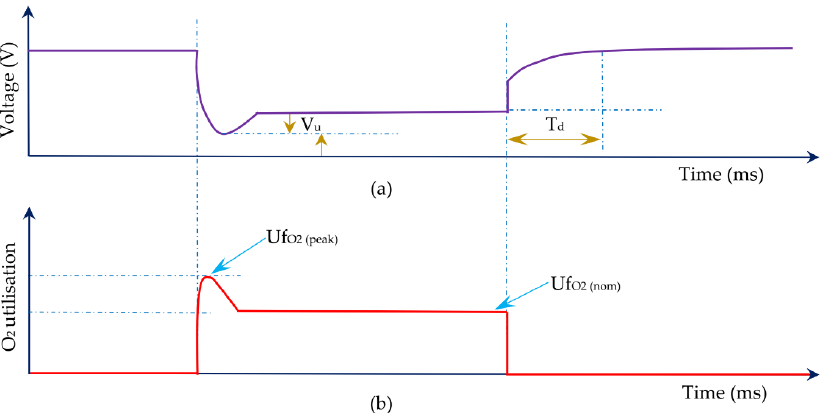
Figure 4. Profiles of voltage ( a ) and O 2 utilisation ( b ) vs. time. Reproduced from [19] under the Creative Commons Licence. Overall, the scheme of the FC stack, including 45 cells, and the details of the block for connection to the grid are exemplified in Figure 5 [19].